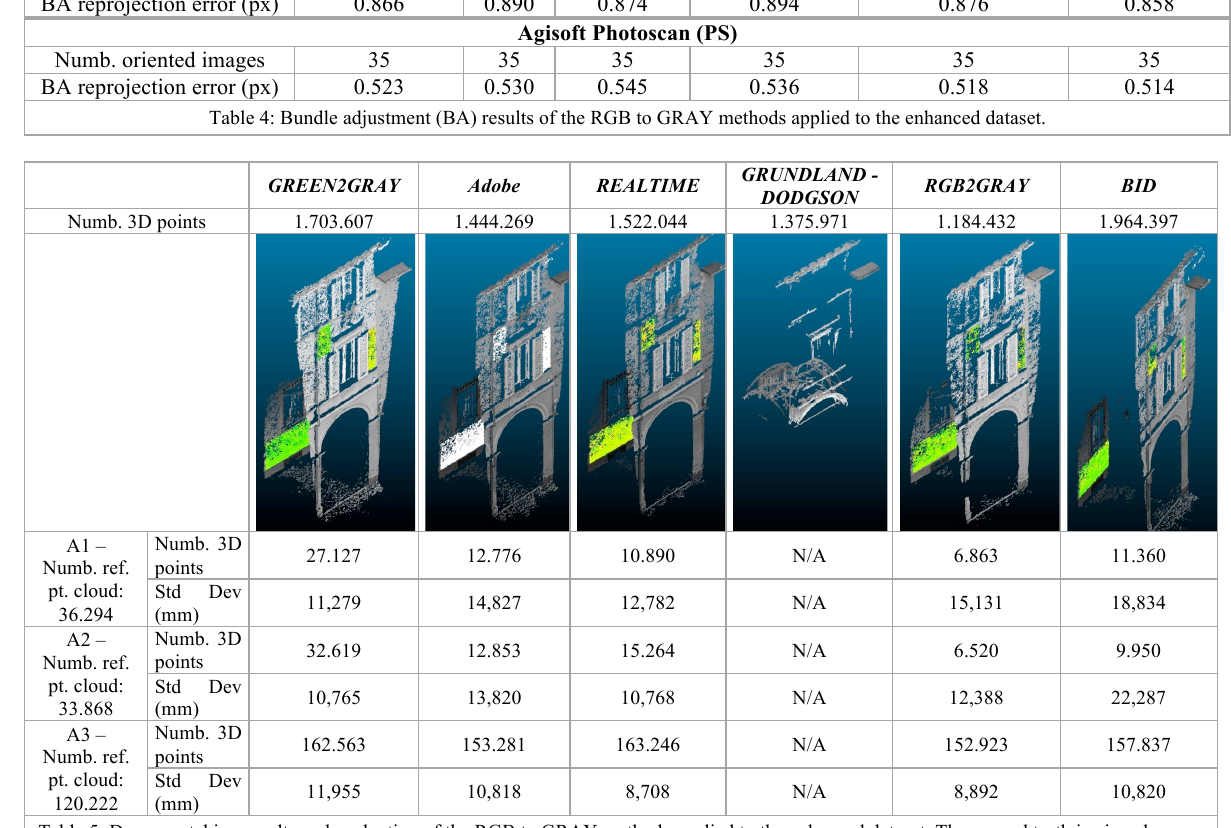
Table 5: Dense matching results and evaluation of the RGB to GRAY methods applied to the enhanced dataset. The ground truth is given by a TLS survey resampled to 5x5 mm